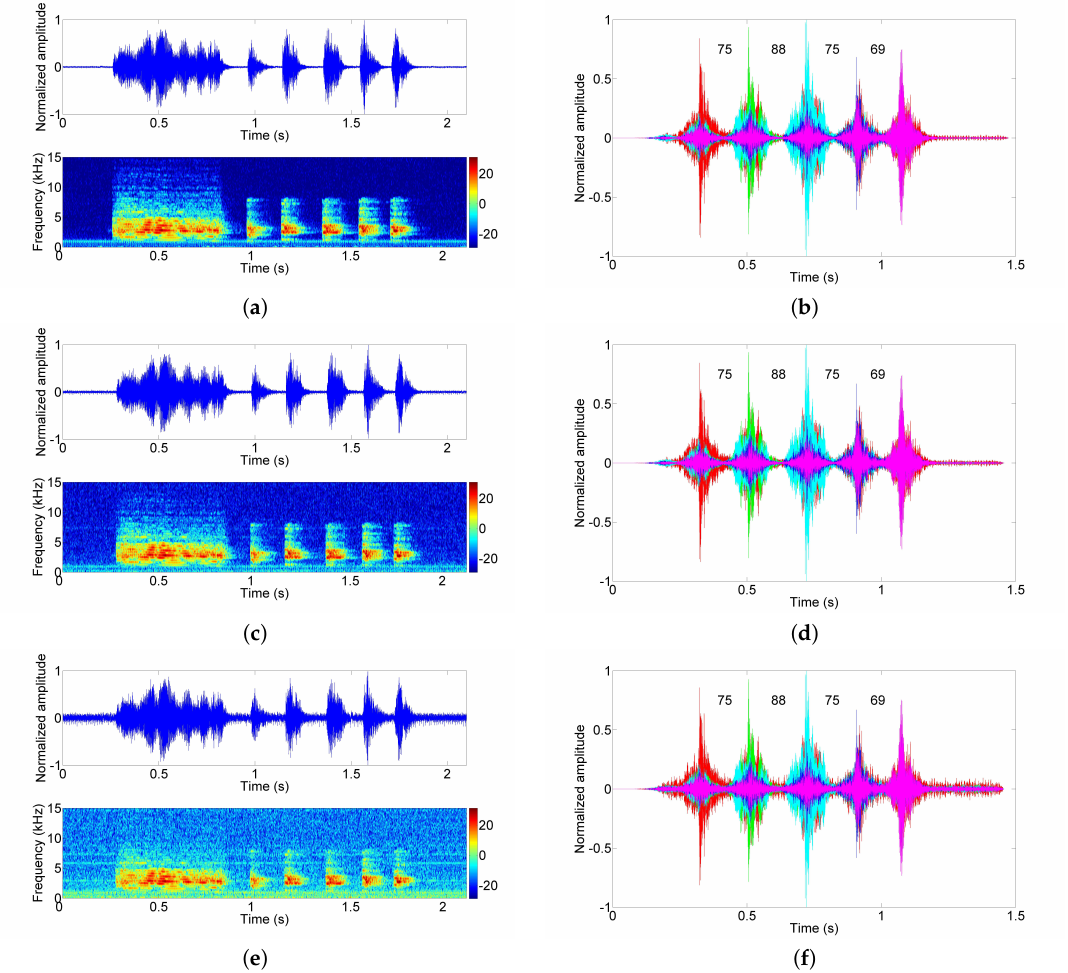
Figure 16. The time–frequency analysis and demodulation results; ( a ) Transmitted dolphin clicks; ( b ) Correlation result of transmitted clicks; ( c ) Received clicks at 7.2 m; ( d ) Correlation result of received clicks at 7.2 m; ( e ) Received clicks at 10 m; ( f ) Correlation result of received clicks at 10